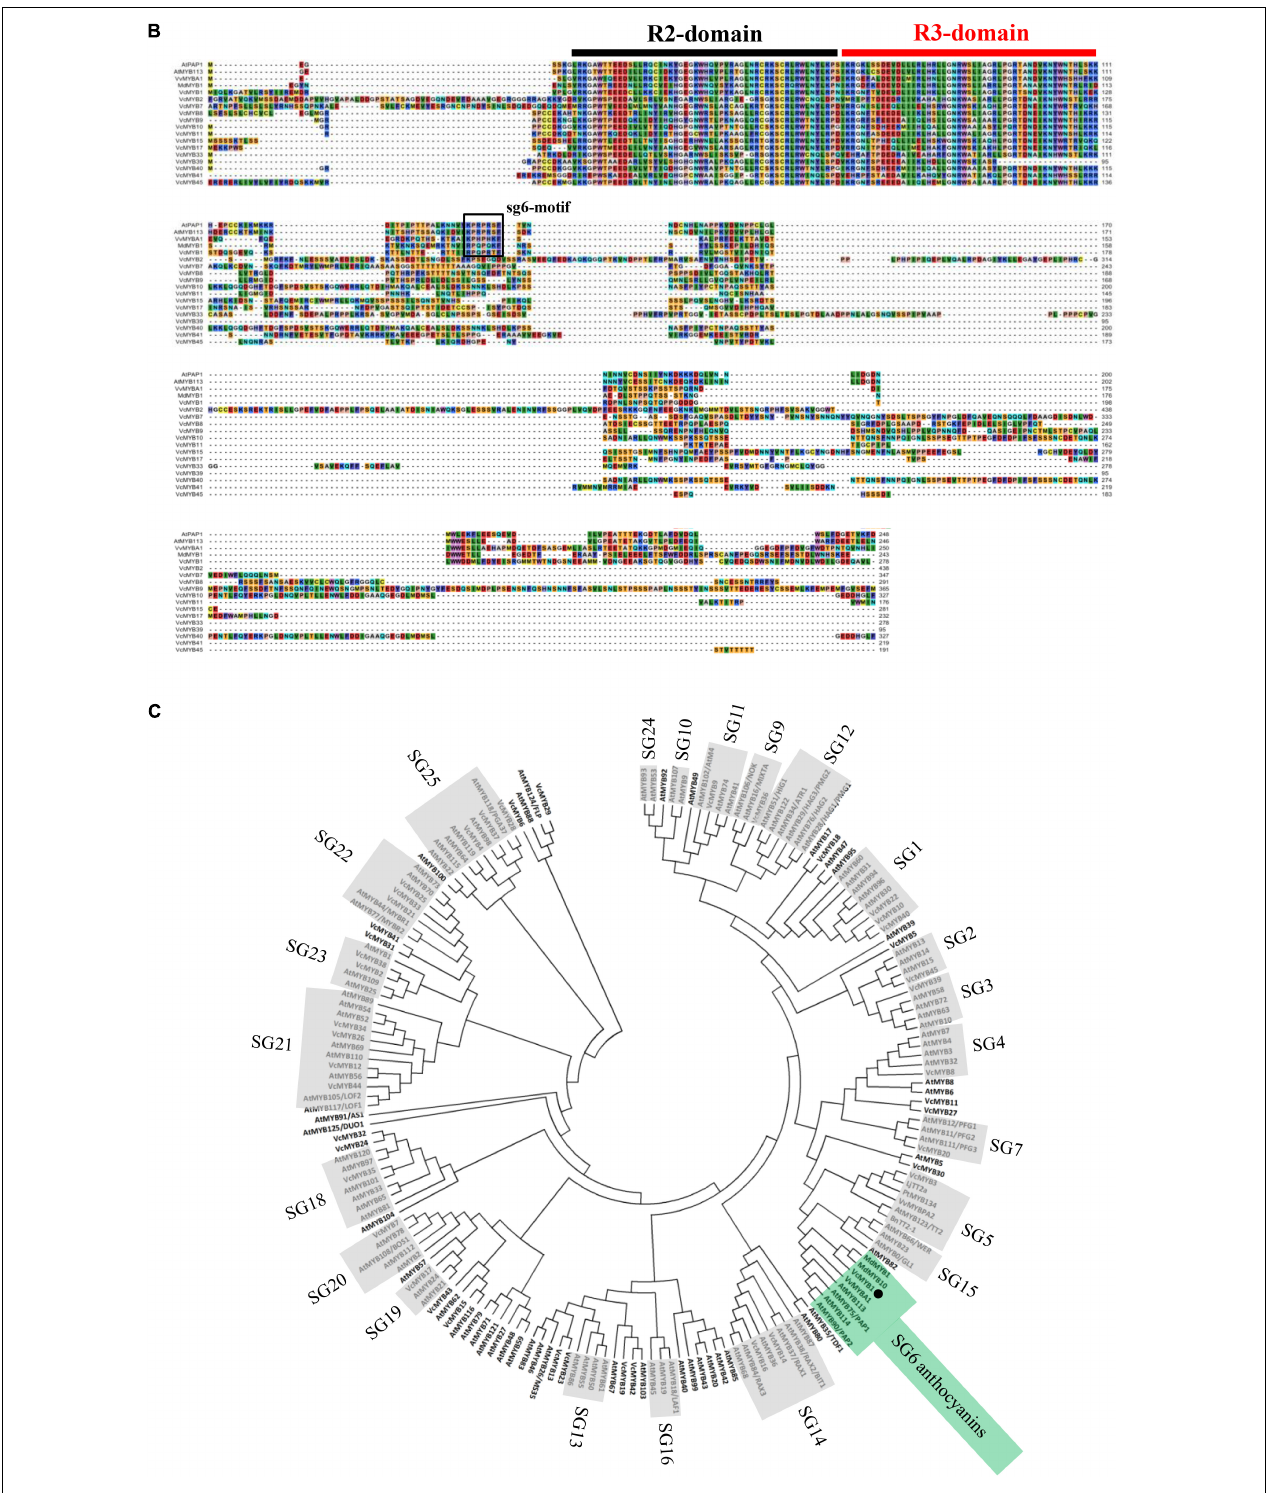
FIGURE 3 | Sequence alignment and phylogenetic analysis of VcMYB. (A) Heat map depicting the various MYBs, qRT-PCR analysis was also carried out for the genes in red. (B) Protein alignment of Vc MYB and its homologs in Arabidopsis, Vitis vinifera and Malus domestica , The sg6-motif in boxed. (C) Phylogenetic analysis of VcMYB and 138 other plants MYB protein sequences obtained from the NCBI database.VcMYB1 is denoted by the black spot. MYB of Arabidopsis (AtMYB0: At3g27920; AtMYB1: At3g09230; AtMYB10: At3g12820; AtMYB100: At2g25230; AtMYB101: At2g32460; AtMYB102: At4g21440; AtMYB103: